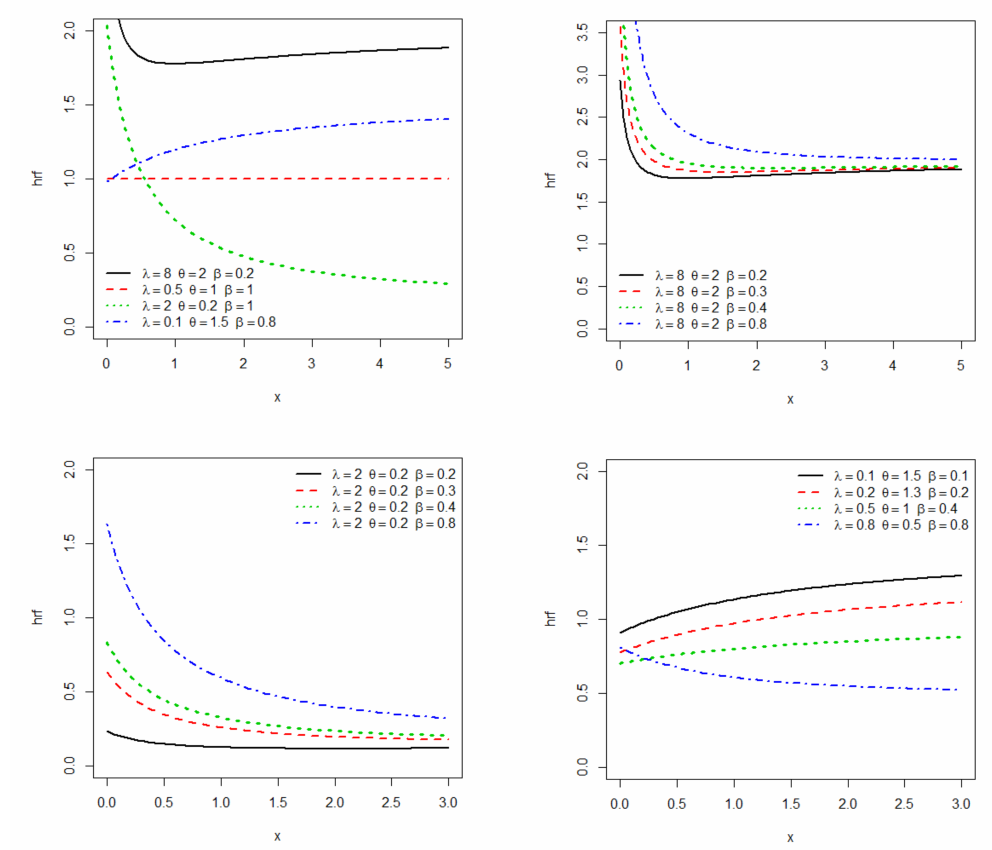
Figure 2. Possible figures of the minLLx hrf for parameter values chosen at